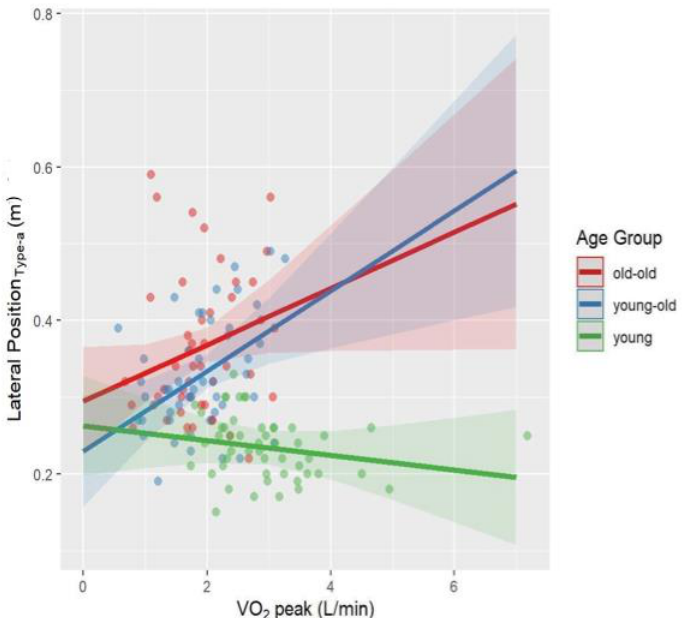
Figure 3. Interaction effect between age and VO 2 peak on Lateral Position Type-a after controlling for BMI and sex. The fit lines represent the trend of the data for subgroups. Green: young adults, Blue: young-old adults, Red: old-old adults. Young adults with higher VO 2 peak drove less laterally, while old-old and young-old adults drove more laterally.